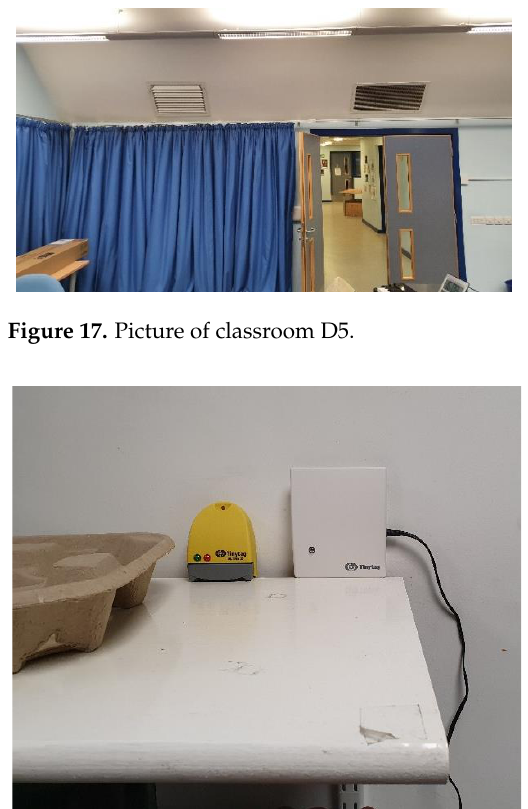
Figure 17. Picture of classroom D5.